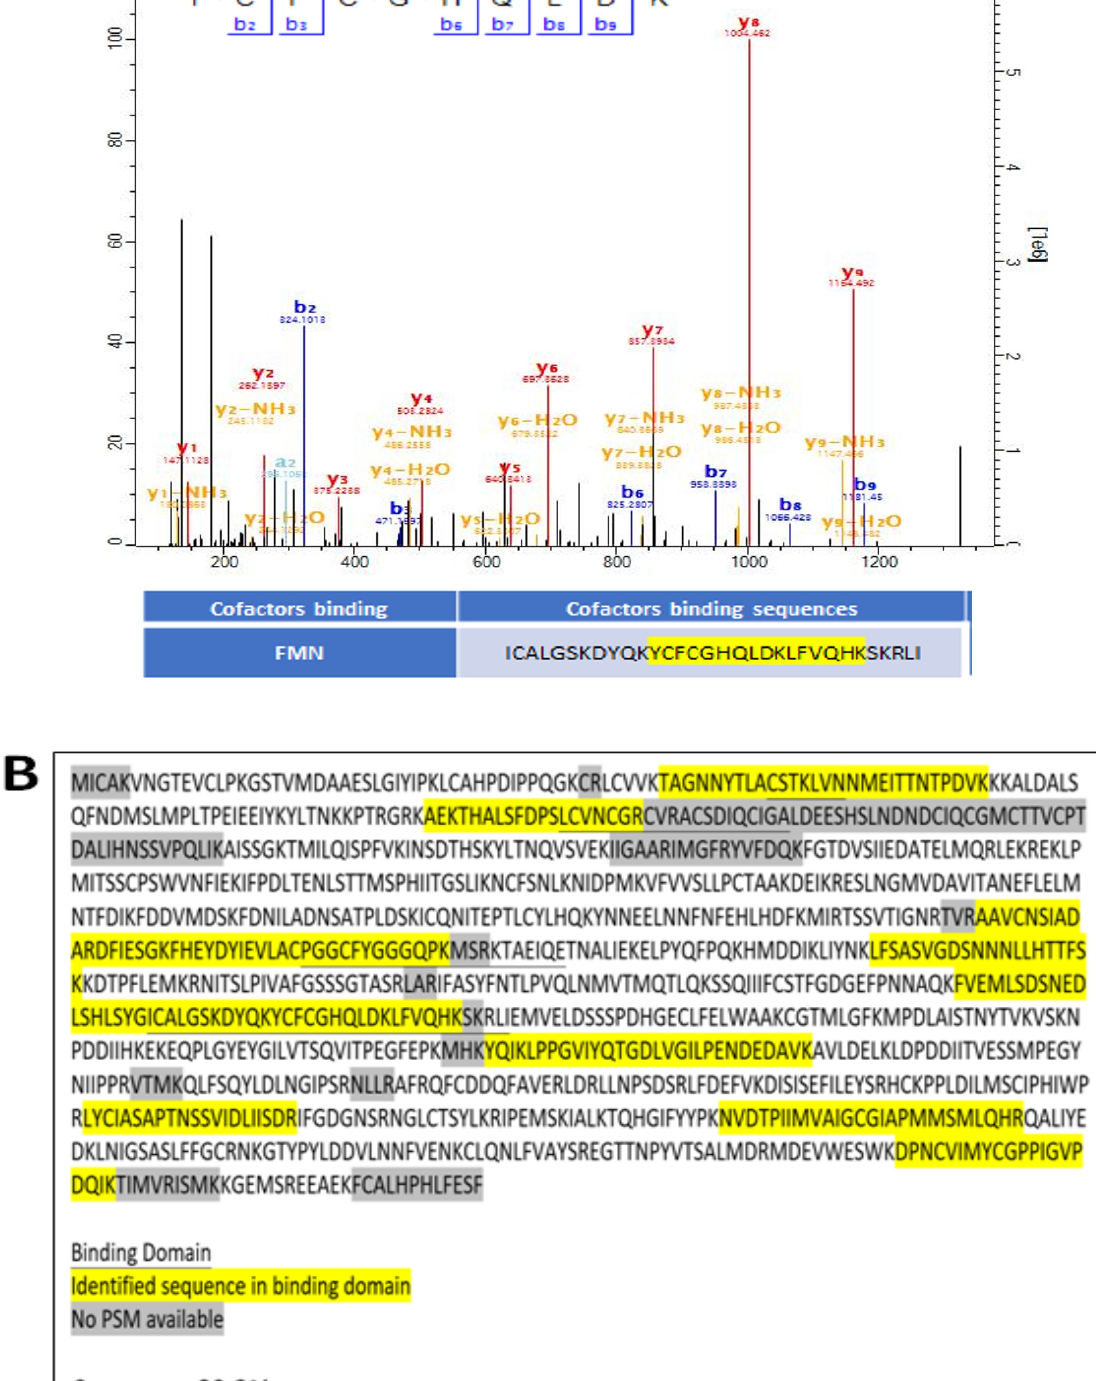
Figure 8. Mass-spectrometry-based sequence analysis of purified TVAG_136330 proteins. Both ( A ) peptide data with daughter ions which match the trypsin-digested FMN-binding sites (YCFCGHQLDK) and ( B ) a high sequence coverage which occupies 88.2% of protein length and includes all cofactor-binding sites indicate that the correct protein was successfully cloned and expressed.